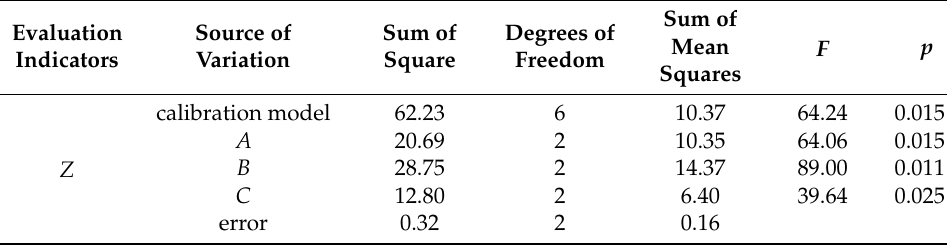
Table 4. Analysis of